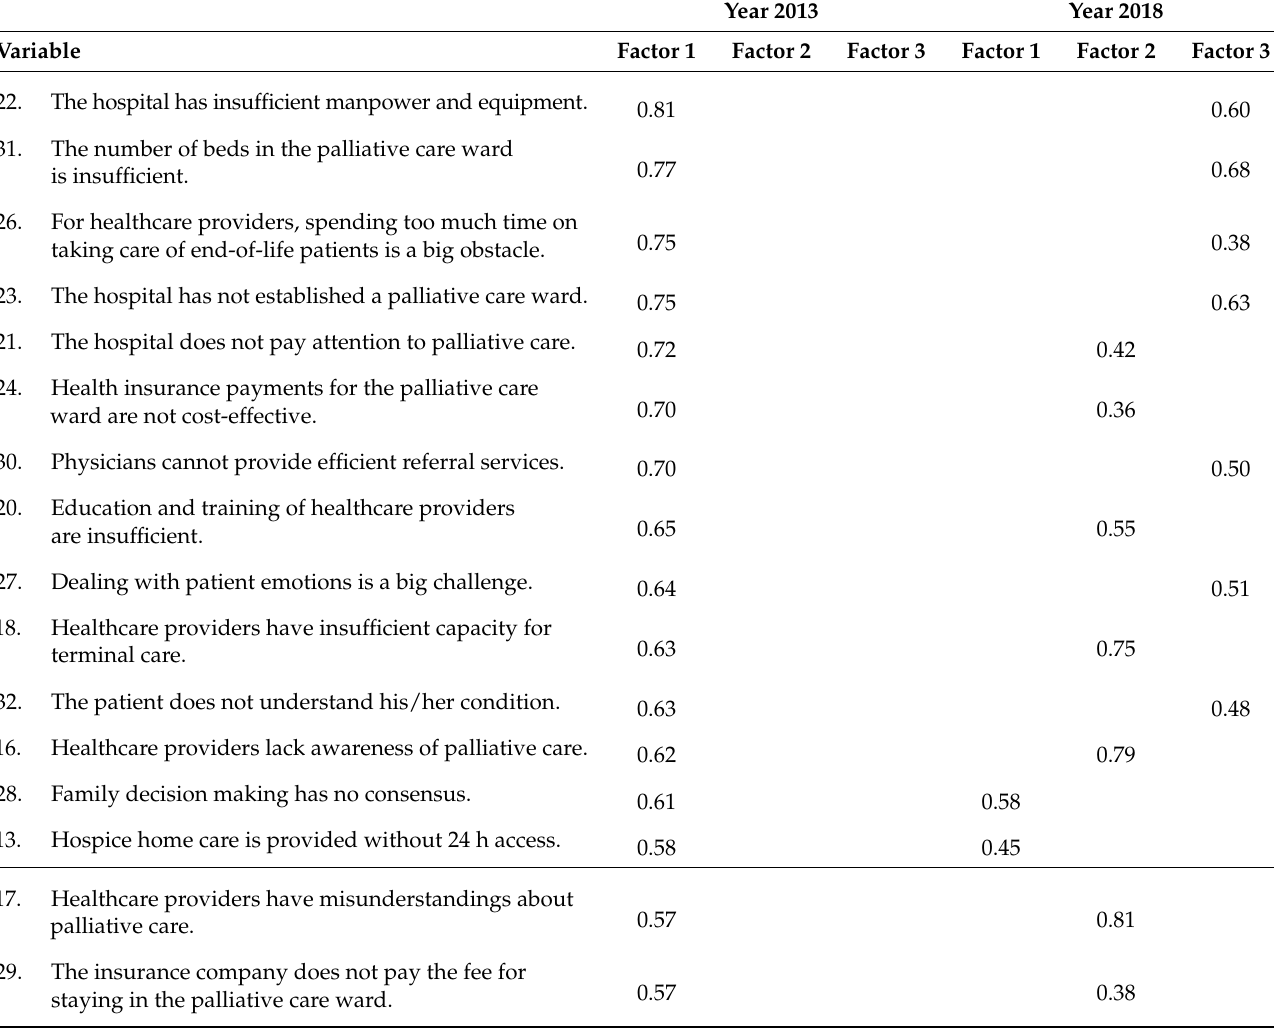
Table 5. Factor loadings for items of the scale of perceived barriers to palliative care in 2013 and